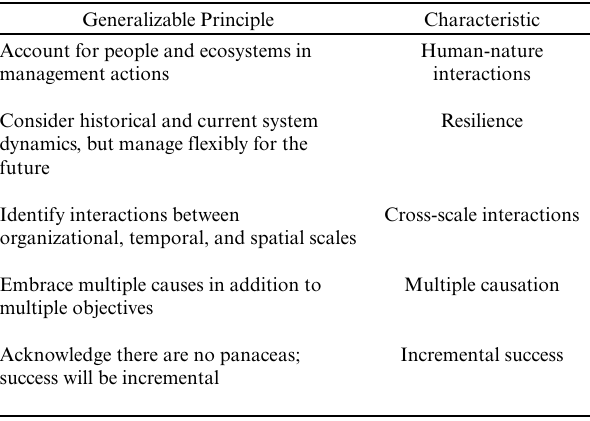
Table 3 . Generalizable principles to foster ecosystem stewardship- based natural resource management, particularly at local scales when transformative institutional change is